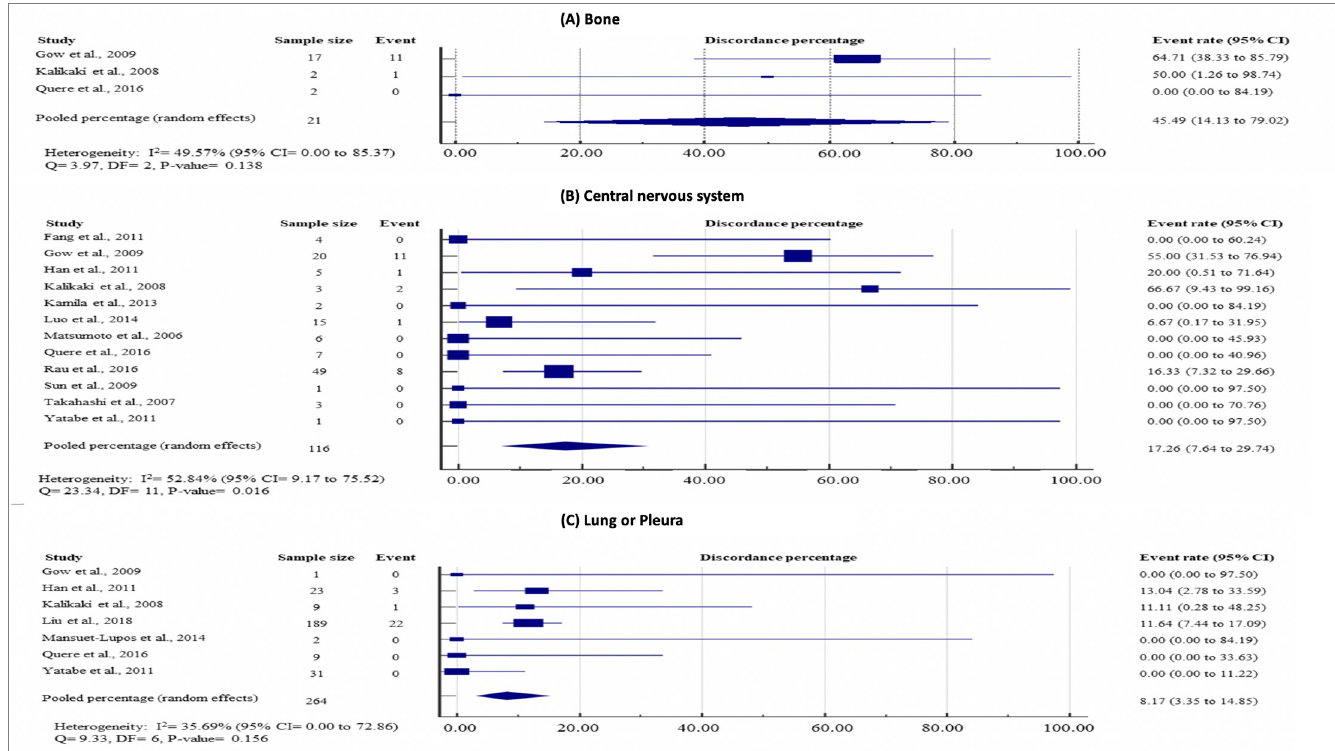
Fig 3. Study-specific and pooled estimates for metastasis location-specific EGFR mutation discordance percentages. (A) Bone; (B) central nervous nystem; and (C) lung or pleura. Heterogeneity was assessed using I 2 and Q test. Event was defined as discordance of EGFR mutation status between primary lung tumor and paired metastases. Abbreviation: DF = degree of freedom; CI = Confidence interval; EGFR = epidermal growth factor status.